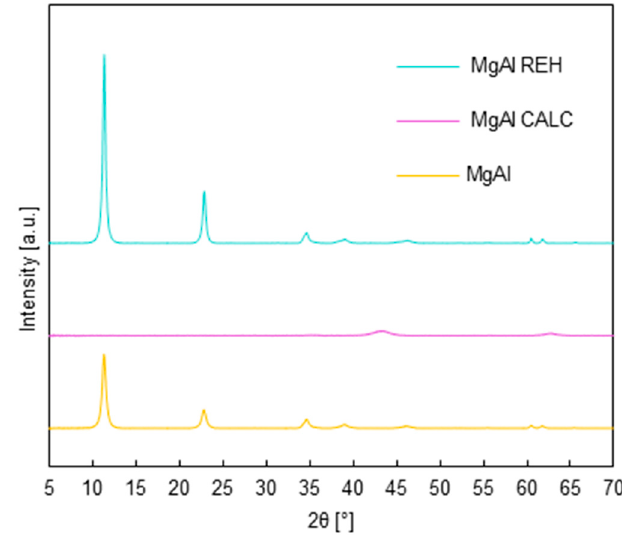
Figure 2. XRD patterns for tested catalysts.